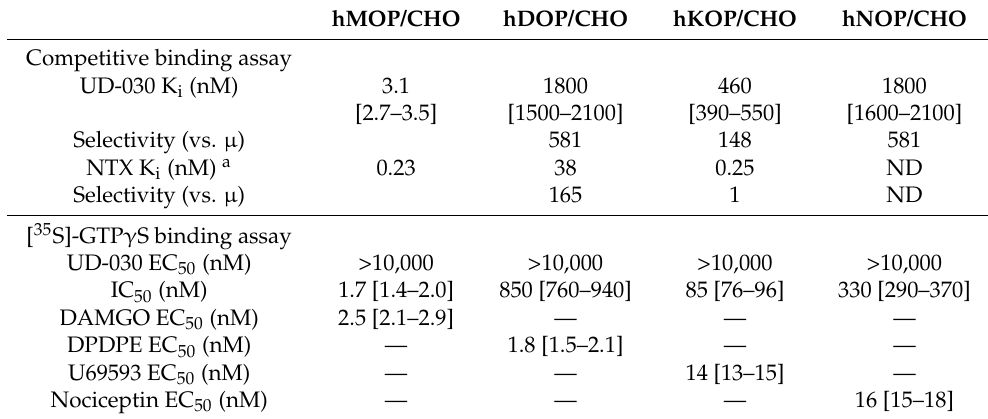
Table 1. In vitro actions of UD-030 and reference compounds against human opioid receptors and the